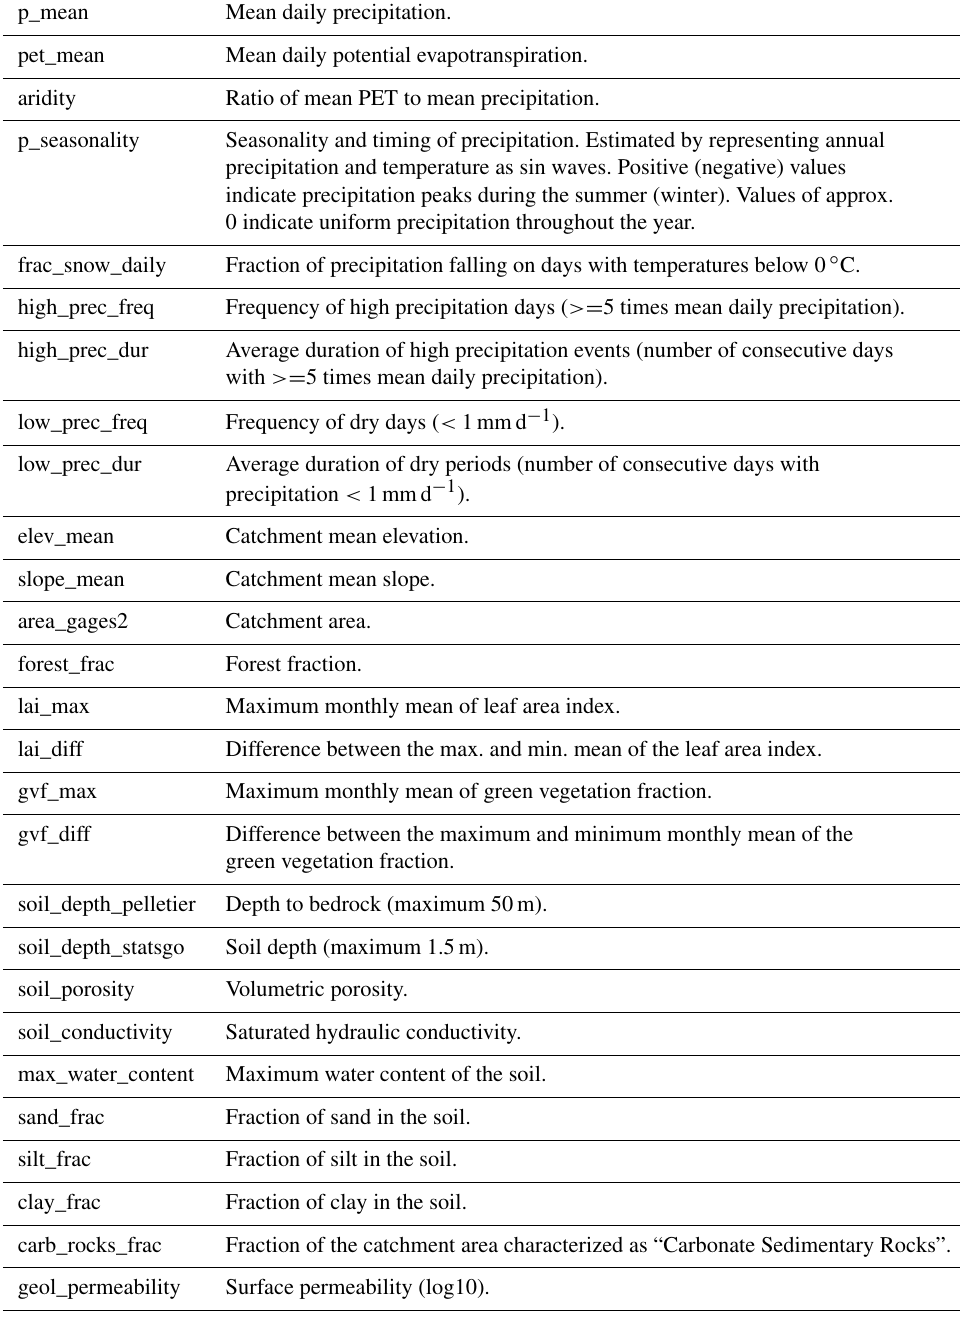
Table G1. Table of static catchment attributes. Descriptions taken from Addor et al.